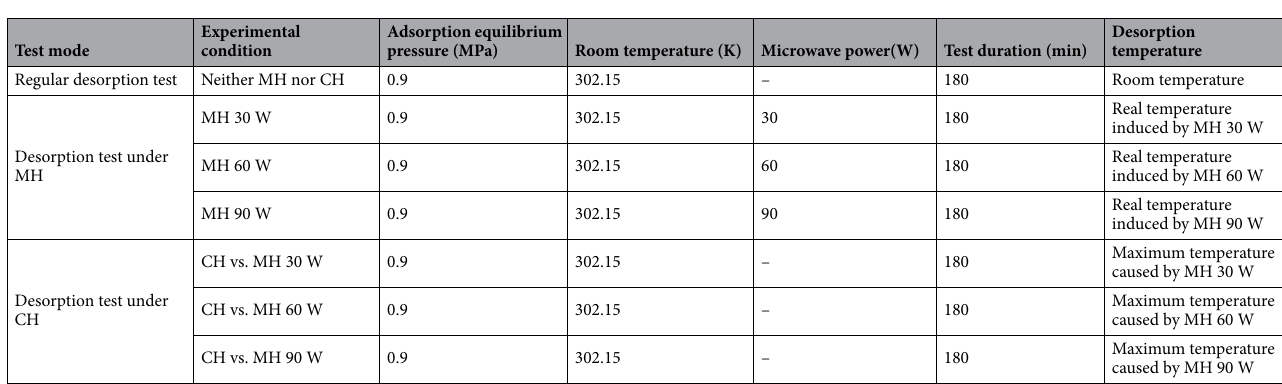
Table 1. Microwave and conductive heating desorption test experimental